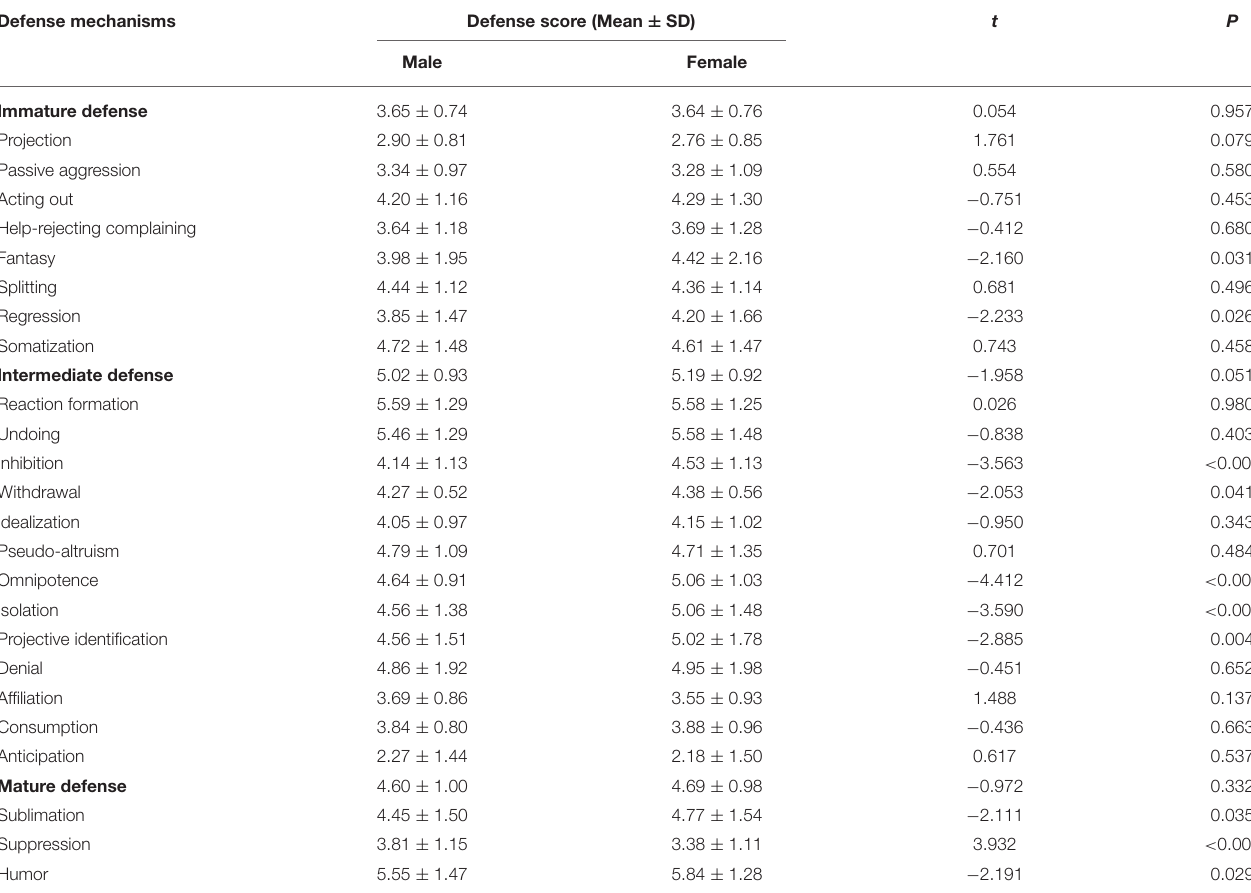
TABLE 6 | Comparison of defense mechanisms between male and female